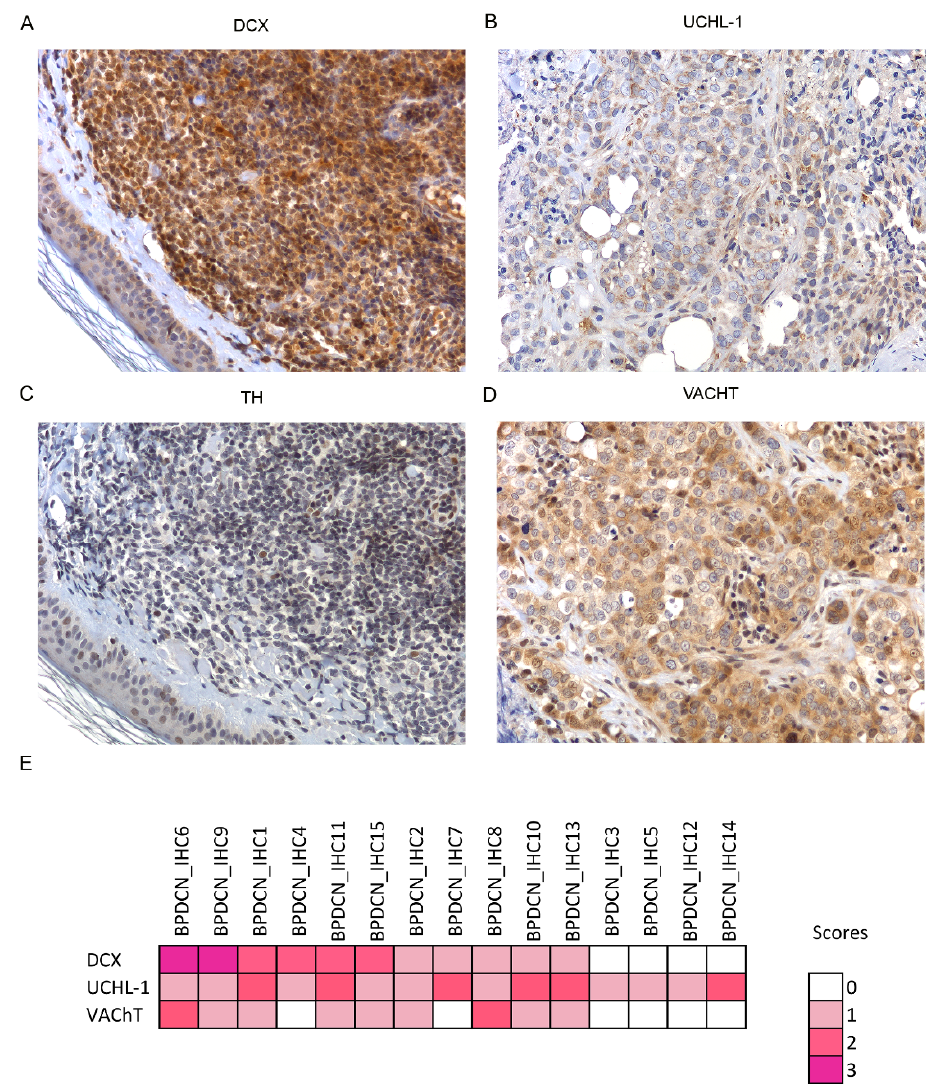
Figure 4. Immunostaining for neural markers in BPDCN. Immunohistochemistry assay shows the positivity for DCX ( A ) UCHL-1 ( B ) and VAChT ( D ), in the BPDCN tumor cells of selected BPDCN samples. ( C ) All the BPDCN samples, except one, were negative for TUBB3 as illustrated. ( E ), Heat map shows the immunophenotypic findings in the 15 BPDCN samples of the immunohistochemistry validation set. The color intensity corresponds to the ordinal score. Microphotographs were collected using a Zeiss Axiocam 503 Color digital camera using the Zen 2.0 imaging software. Original magnifications × 20.